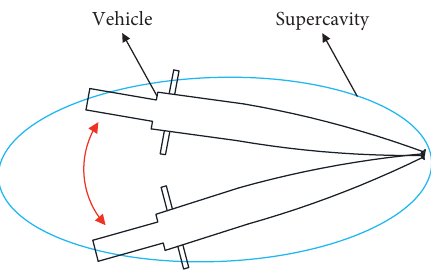
Figure 5: Tail-slap phenomenon of SVs.